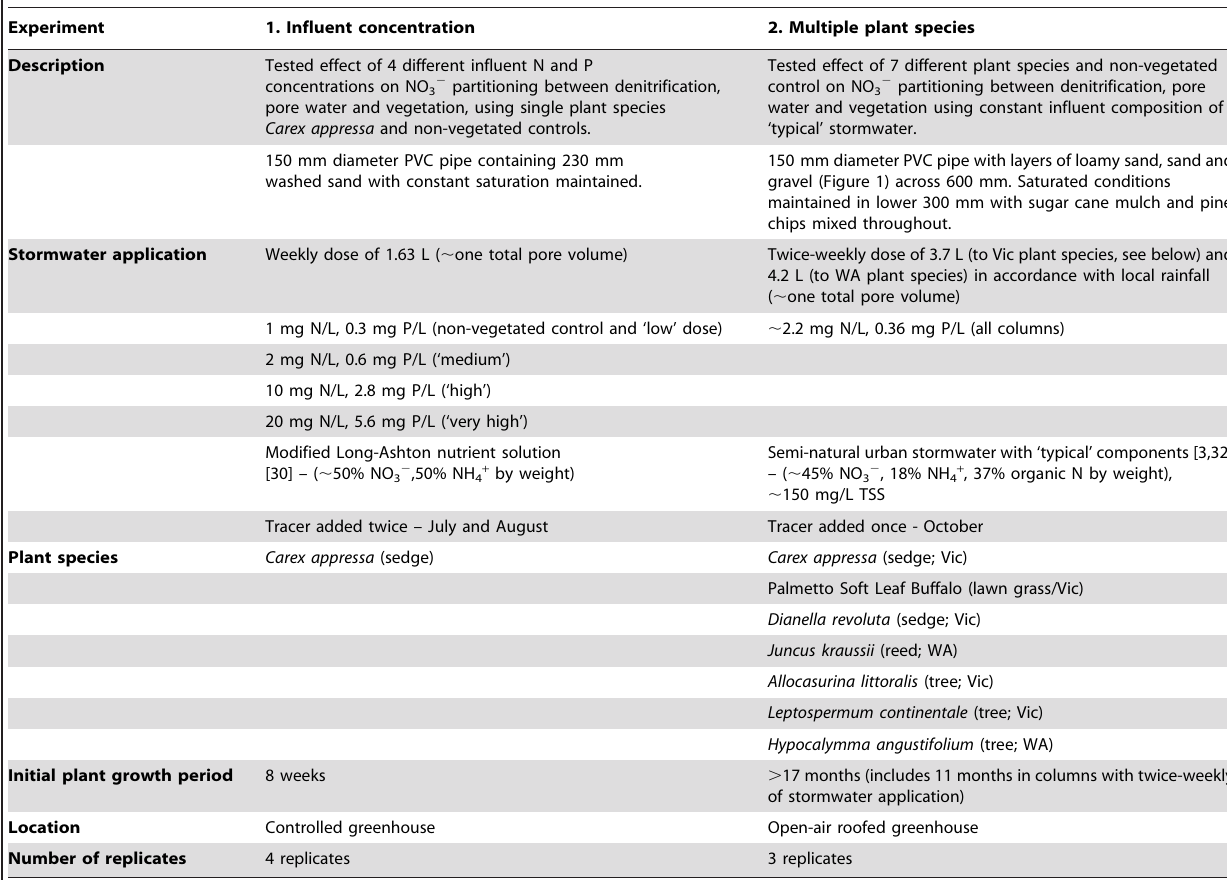
Table 1. Summary of experiment